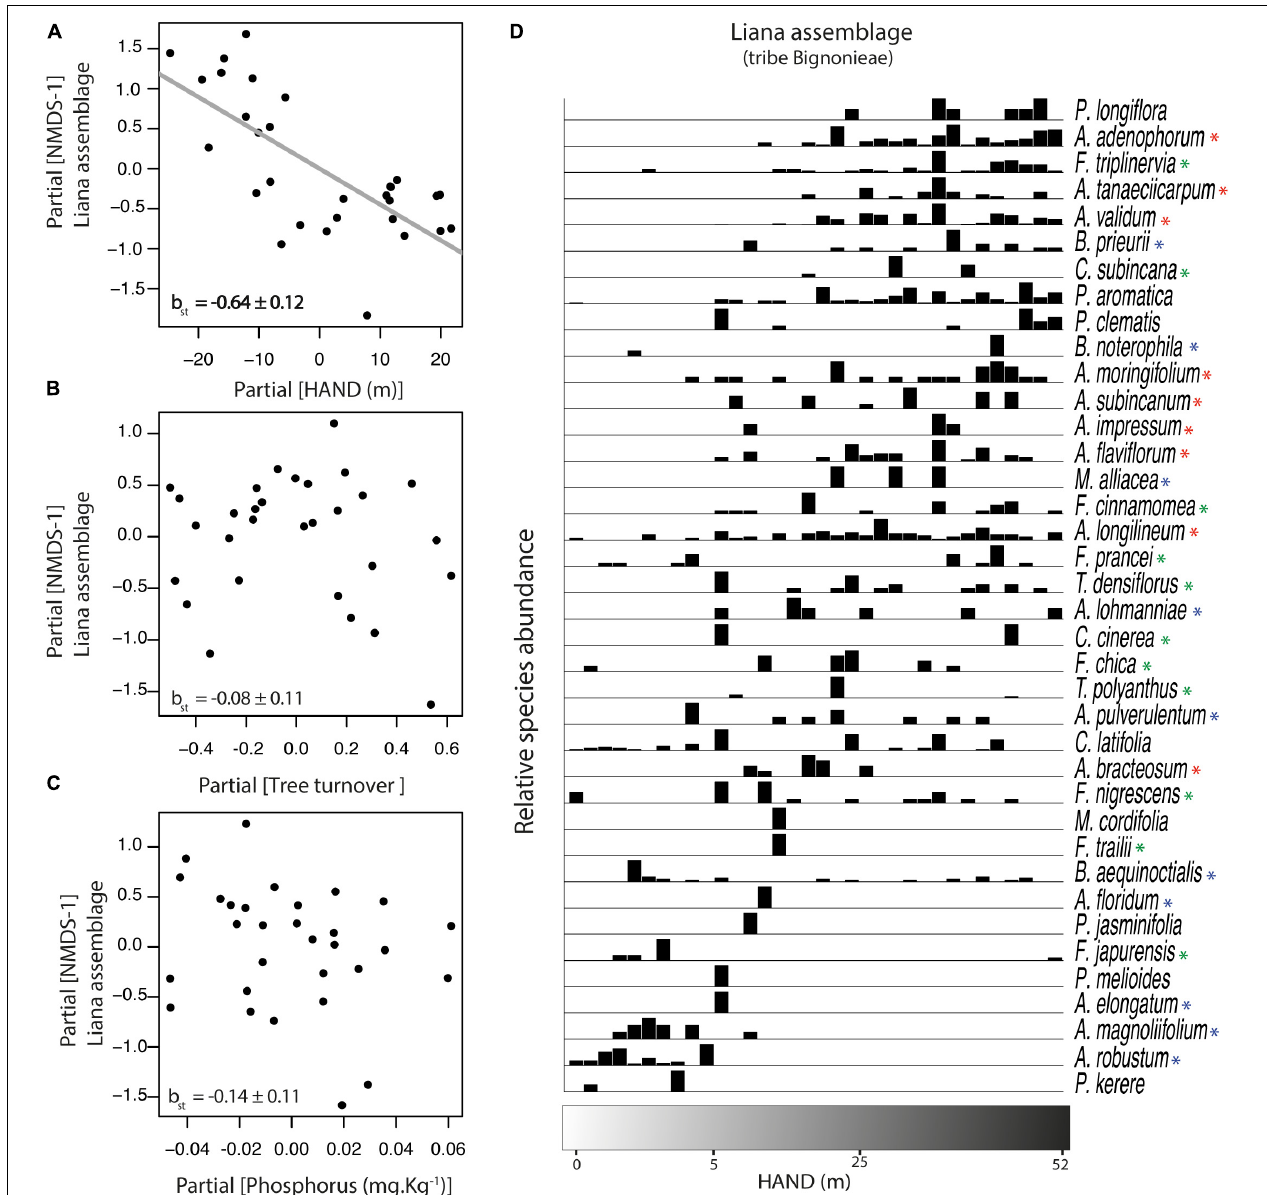
FIGURE 3 | Relationship between liana species composition (NMDS-1) and the three environmental gradients at Ducke Reserve (Central Amazon, Brazil). Relationships (A–C) are partial regressions from models, including HAND (height above the nearest drainage), tree turnover and soil P concentration as predictive variables. The gray line represents a significant relationship ( p < 0.05). Standardized multiple linear regression coefficients ( β st ± SE) are shown in the graphs. (D) Species abundance distribution on the 34 plots is based on direct ordination along the HAND gradient. See Figure 1 for abbreviations of scientific terms. Red, blue, and green asterisks highlight the three main clades of the tribe Bignonieae: Adenocalymma , Multiples-of-Four, and Fridericia-and-Allies,